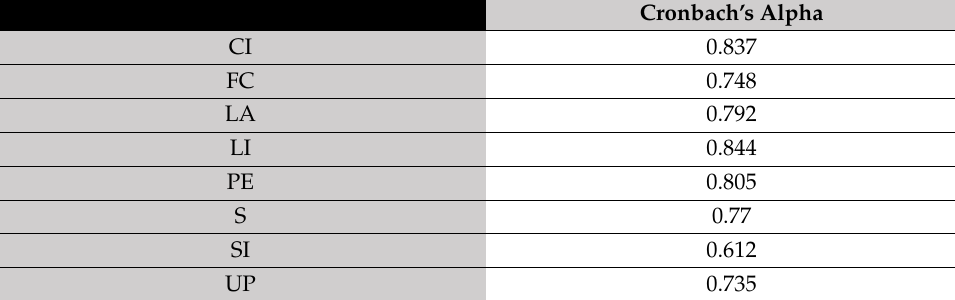
Table 12. Cronbach’s